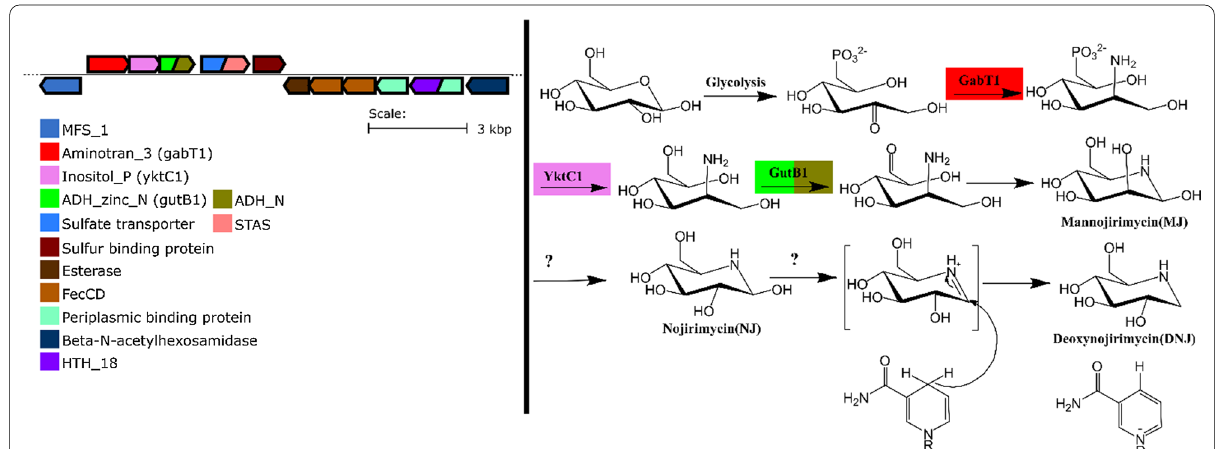
Fig. 2 DNJ biosynthesis in B. velezensis (formerly B. amyloliquefaciens FZB42). Genome Neighborhood Diagram from B. amyloliquefaciens FZB42 adapted from EST-EFI tool (https:// efi. igb. illin ois. edu/ efi- gnt/) not pictured upstream of the MFS transporter are tRNA